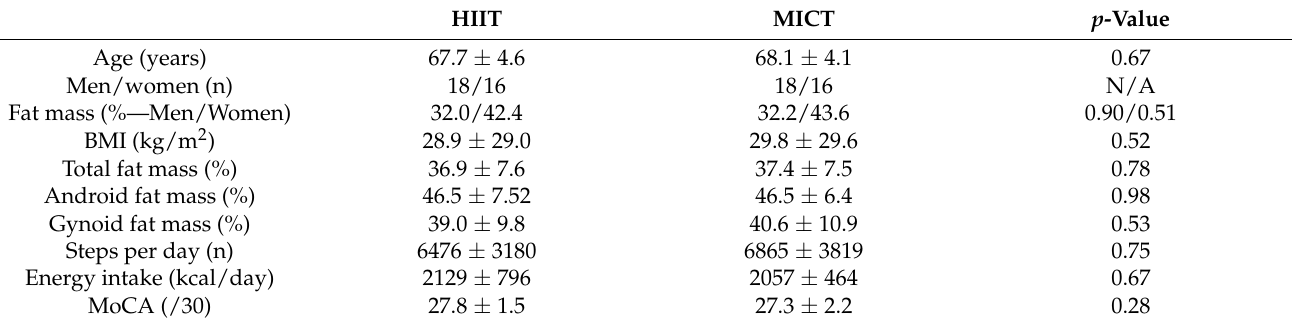
Table 1. Characteristics of participants at baseline.